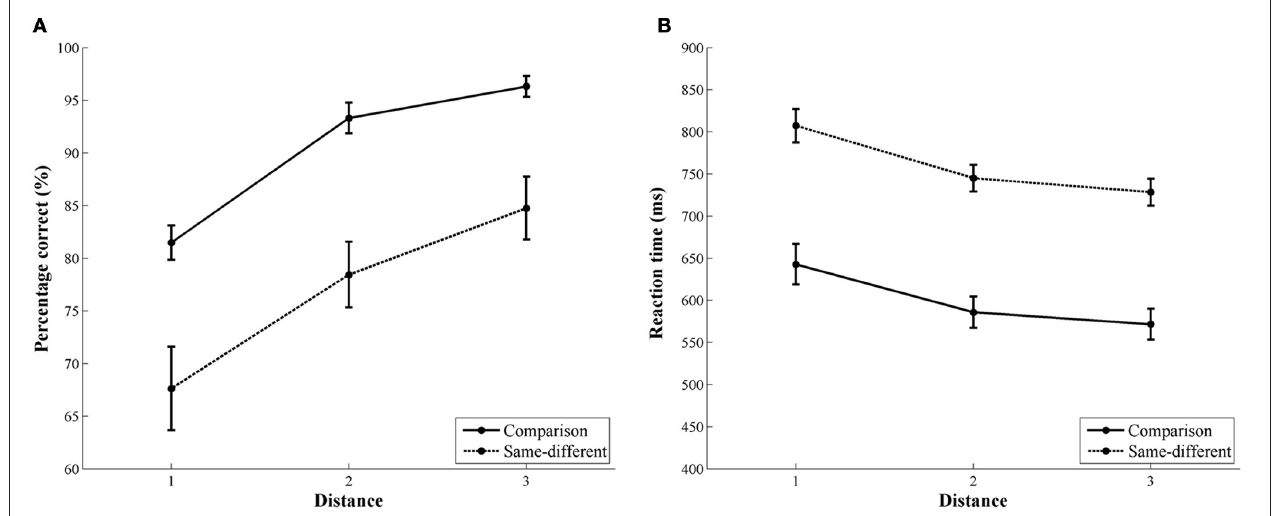
FIGURE 2 | Behavioral results of the comparison and the same-different task. The left image (A) represents the accuracy rate for the comparison (solid line) and the same-different task (dotted line). The right image